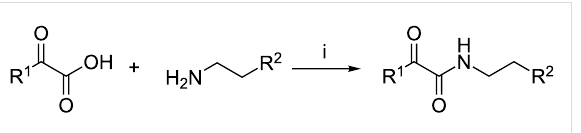
Scheme 1: General procedure for the synthesis of nematophin and related derivatives. i) 1.5 equiv α -keto carboxylic acid, 1.0 equiv